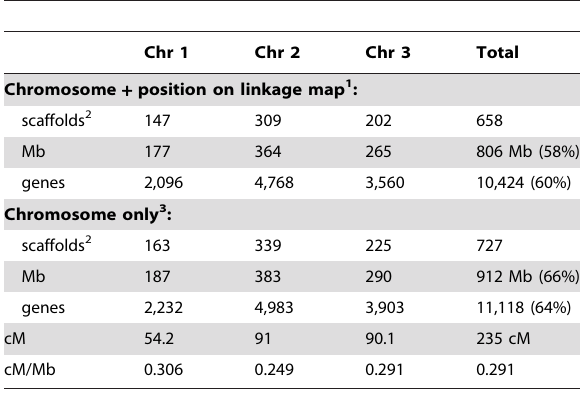
Table 1. Summary of our assembly of the genome onto a genetic map.